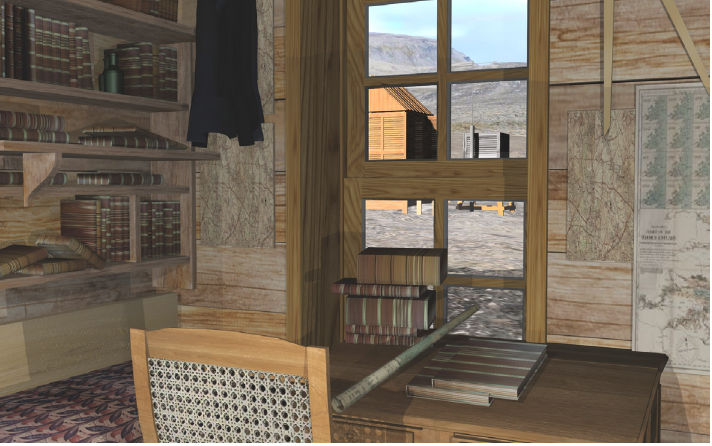
Figure 12. The view from Lt. Lockwood’s window of the observatory, allowing for the monitoring of regular scientific